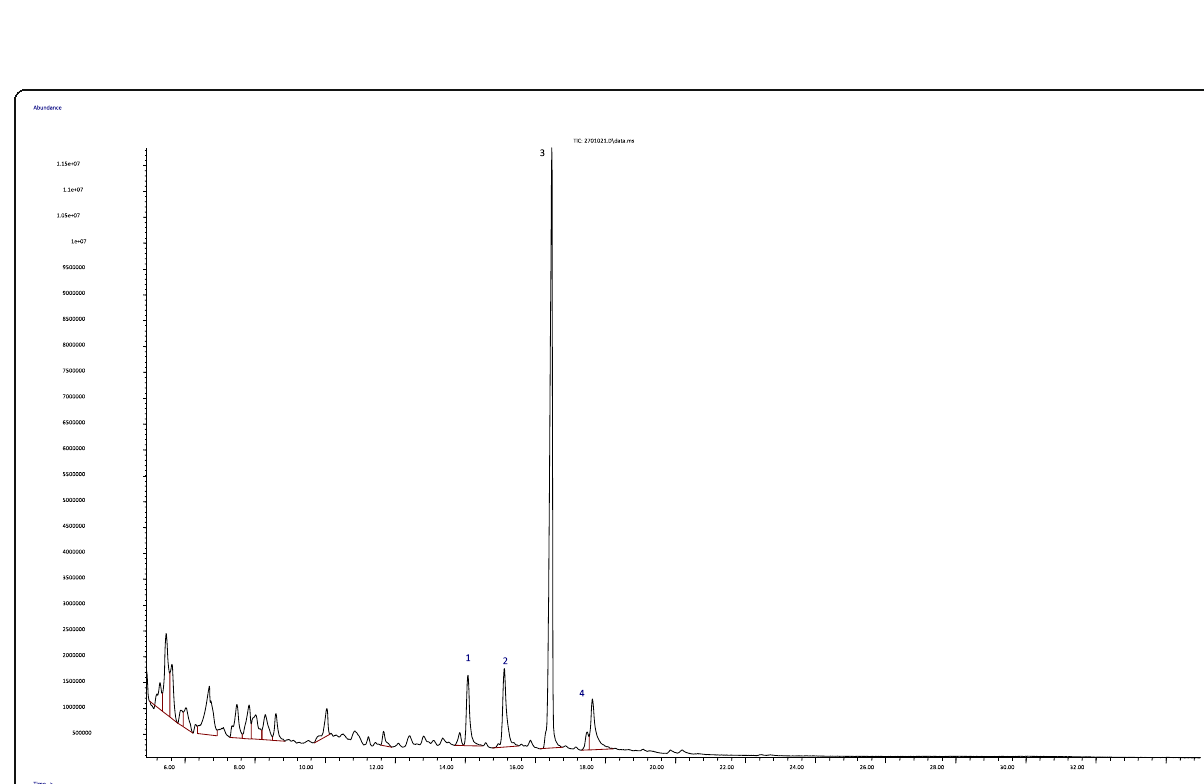
Fig. 13 GC-MS Chromatogram of Commiphora swynnertonii methanolic stem bark extract. The labeled number represents: (1) Hexadecane-1,2-diol, (2) 9-Eicosene, (E)-, (3) Borneol, (4) Dichloroacetic acid, tridecyl